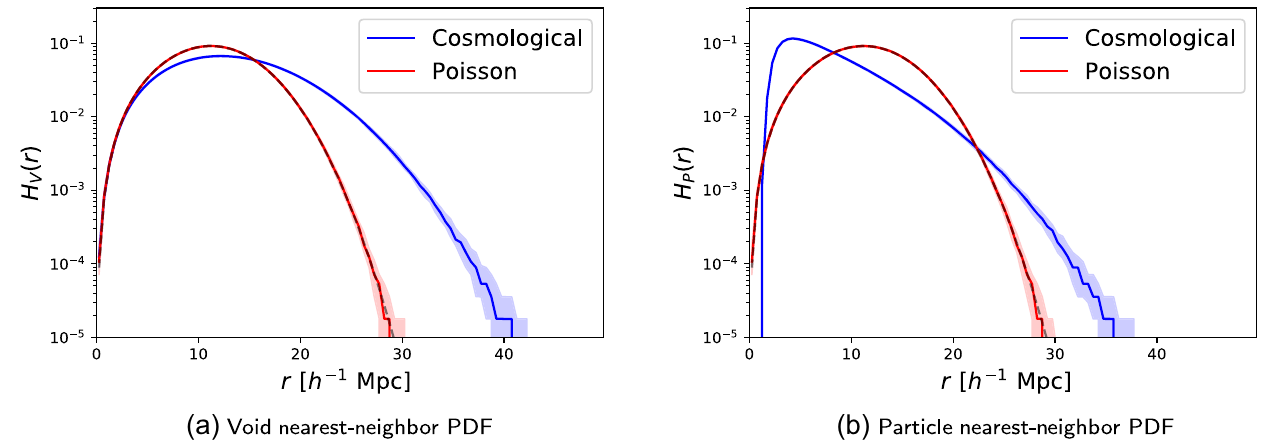
FIG. 5. Comparison of the void and particle nearest-neighbor probability density functions for the cosmological and Poissonian dataset, as defined in Eqs. (14) and (15). Panel (a) shows the probability distribution of finding a void of radius r in the cosmological (blue) and Poisson (red) datasets, averaged over 100 realizations, while panel (b) gives the distribution function of the distance of a given particle from its nearest neighbor. For the Poisson case, the dashed lines show theory curves (defined in Sec. II C), which are in excellent agreement with the simulations. The void distribution in the QUIJOTE simulations follows the (mean-density-matched) Poisson distribution at small r , but has an excess of large voids (shown by much broader tails), due to the quasi-long-range correlations. In r Þ differs between the cosmological and Poissonian simulations on all scales, notably with an contrast, the particle distribution H P ð absence of small separations (due to halo exclusion effects) and an enhancement on large